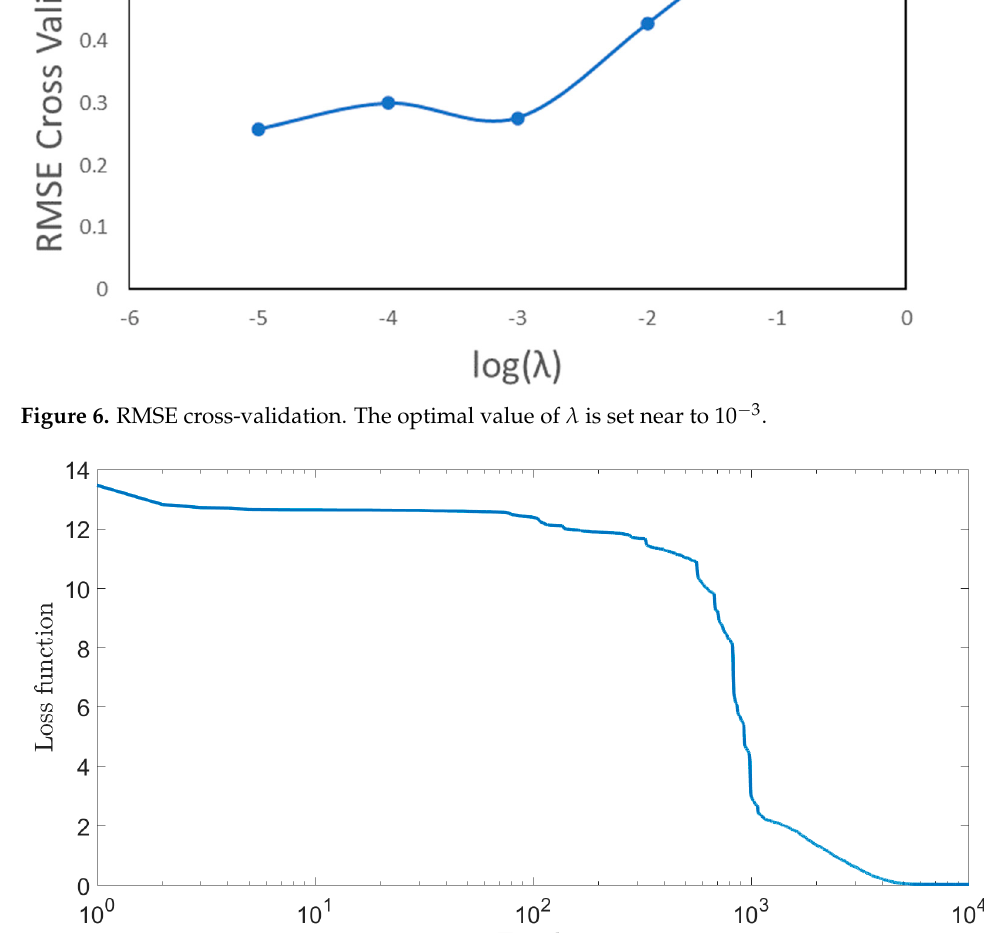
Figure 7. Loss function versus the number of epoch. The optimal value of epoch is 10,000 giving a loss cost value 0.0332.